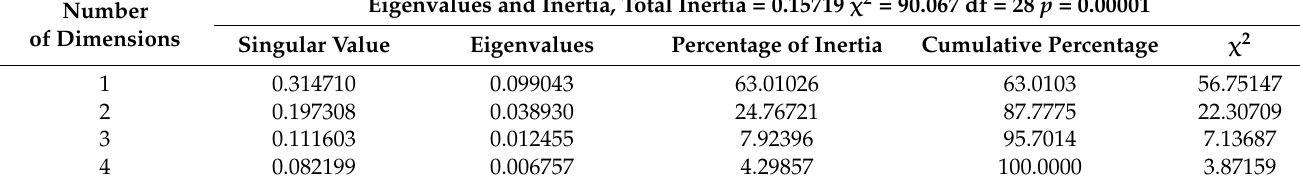
Table 1. Information resources’ factors.